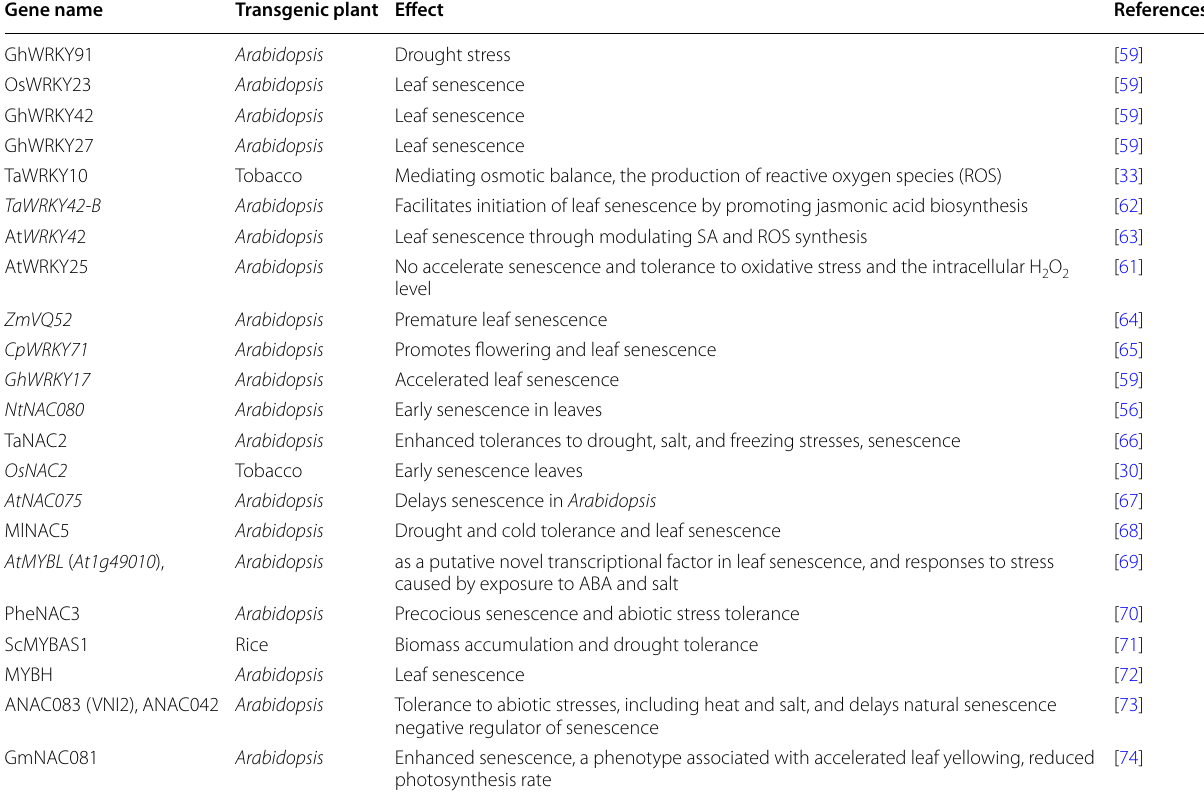
Table 2 The transgenic plants developed by overexpressing the transcription factors Gene